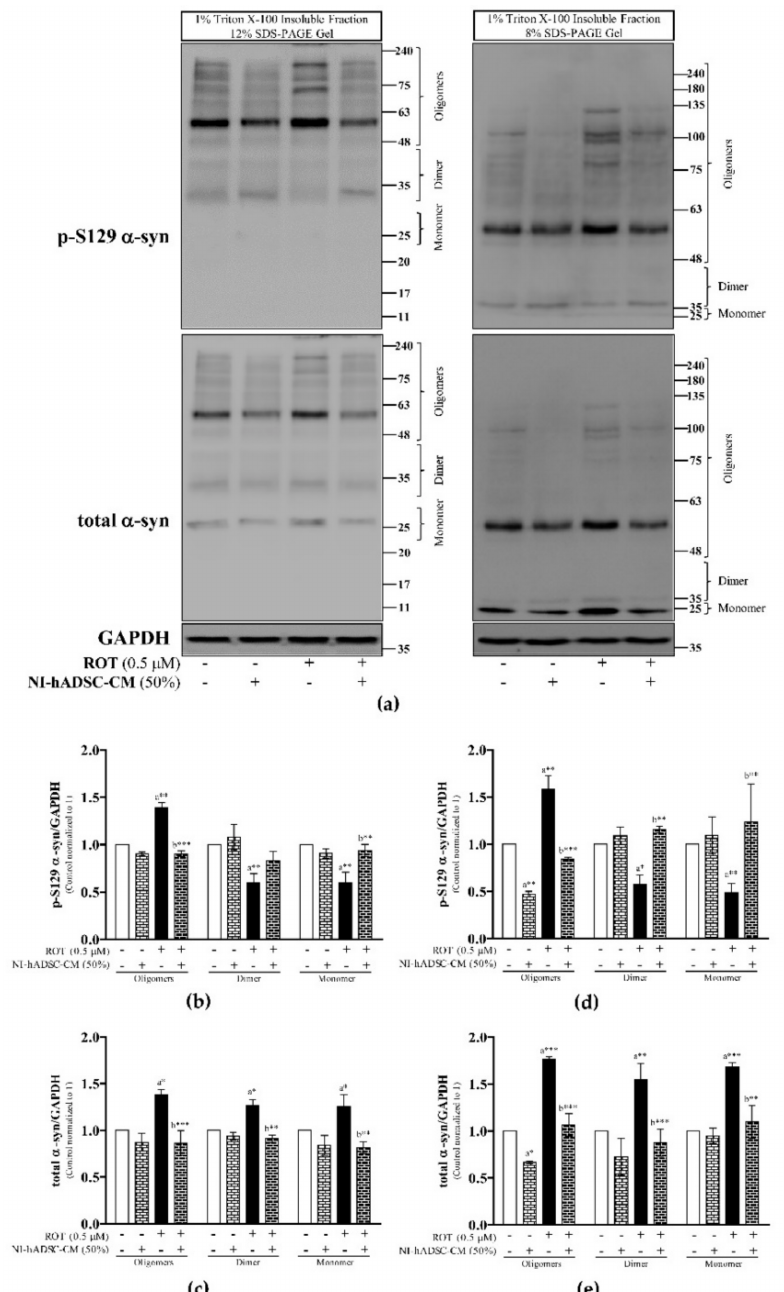
Figure 4. Effects of NI-hADSC-CM against ROT on p-S129 and total α -syn expressions in Triton X-100-insoluble cell lysate fractions. SH-SY5Y cells were seeded at a density of 5 × 10 4 cells/mL in DMEM containing 1% FBS and used for experiments after overnight incubation. Cells incubated in the absence or presence of ROT (0.5 µ M) for 48 h were treated with NI-hADSC-CM (50%) during the last 24 h. Cell lysates were prepared as 1% Triton X-100 soluble and insoluble (2 × SDS-soluble) fractions. The expression levels of p-S129- and total α -syn were analyzed from 1% Triton X-100 insoluble (2 × SDS soluble) fractions by Western blotting using 12 and 8% SDS-PAGE gels ( a ). Images are representative of three independent experiments. The bar graphs represent fold changes in p-S129 α -syn/GAPDH ( b , d ) and total α -syn/GAPDH ( c , e ) in 12% ( b , c ) or 8% ( e ) SDS-PAGE gels. Data are presented as the mean ± SEM of three independent experiments. Statistical analysis was performed using one-way analysis of variance (ANOVA) followed by Tukey’s post hoc test. Statistical significance: a—compared with control; b—compared with ROT; * p < 0.05, ** p < 0.01, and *** p <